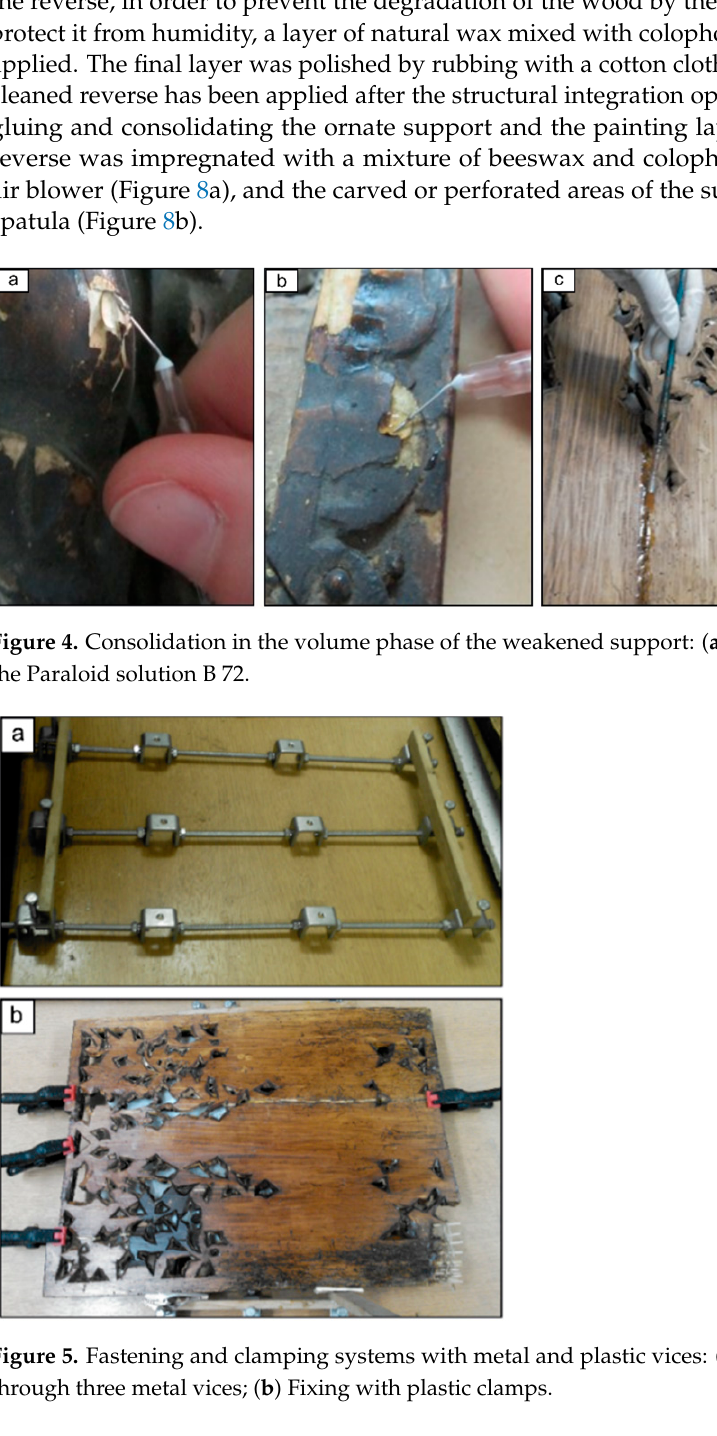
Figure 3. Preventive treatment against xylophagous attack by brushing with 2% Permethrin solu ‐ tion ( a , b ).